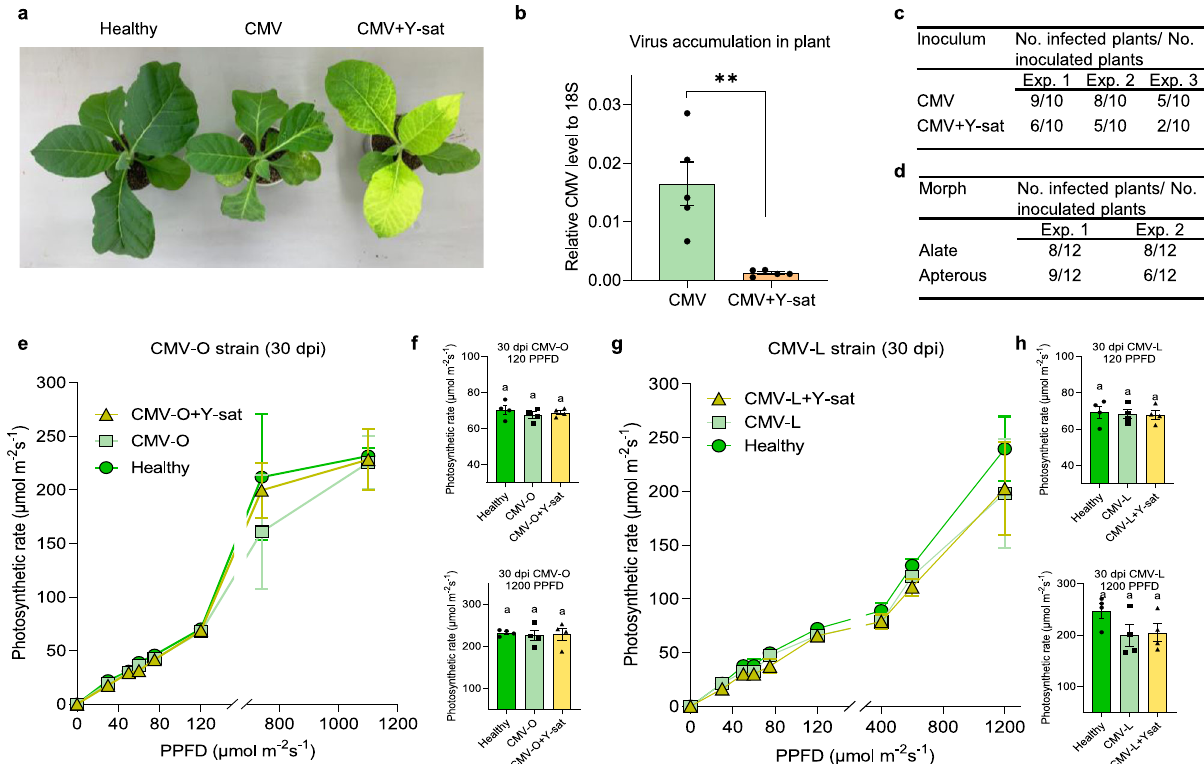
Fig. 1 Effect of Y-satellite (Y-sat) infection on tobacco growth and virus transmission by aphids. a Yellowing was induced in (cucumber mosaic virus [CMV] + Y-sat)-infected plants but not the CMV-infected or healthy at 14 d.p.i. Note that [CMV + Y-sat]-infected plants had few abnormally shaped leaves. b Each data point represents the relative CMV levels in CMV- and [CMV + Y-sat]-infected plants determined by qPCR. Data are mean values (±SE) (two-sided t test, n = 5, P = 0.0037). ** P < 0.01. c Ef fi ciency of aphid transmission of virus from CMV-infected and [CMV + Y-sat]-infected plants to healthy plants ( χ 2 test, P = 0.0352). d CMV transmission ef fi ciency by apterous and alate aphids ( χ 2 test, P > 0.9999). e – h Mean (±SE) photosynthetic rate in CMV-O (or -L)-infected, [CMV + Y-sat]-infected and healthy leaves at 30 d.p.i. at various photosynthetic proton fl ux densities (PPFD) µ mol m − 2 s − 1 . Individual data points are mean values of each plant ( e , n = 4; g , n = 3). f , h Mean (±SE) photosynthetic rate among infection